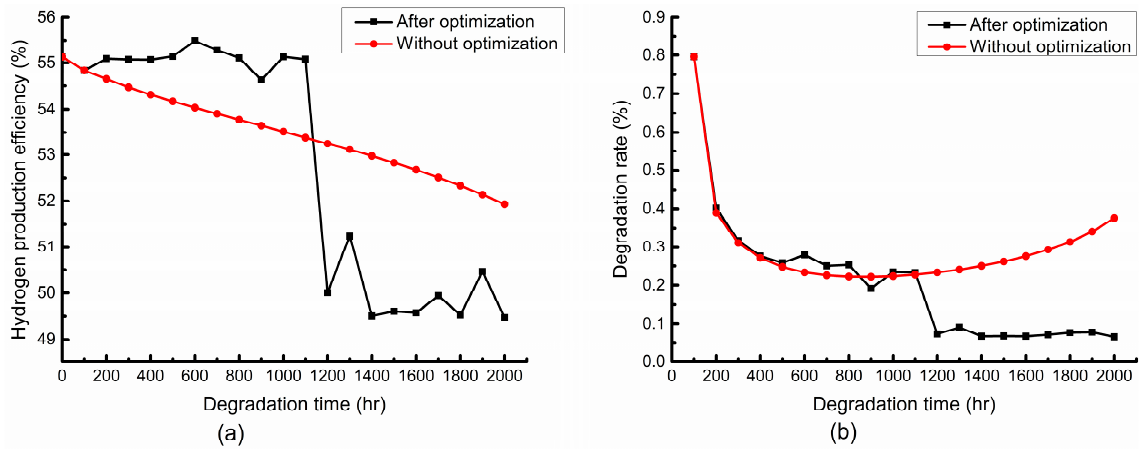
Figure 9. Variation trends of ( a ) hydrogen production efficiency and ( b ) stack degradation rate in the optimization process.